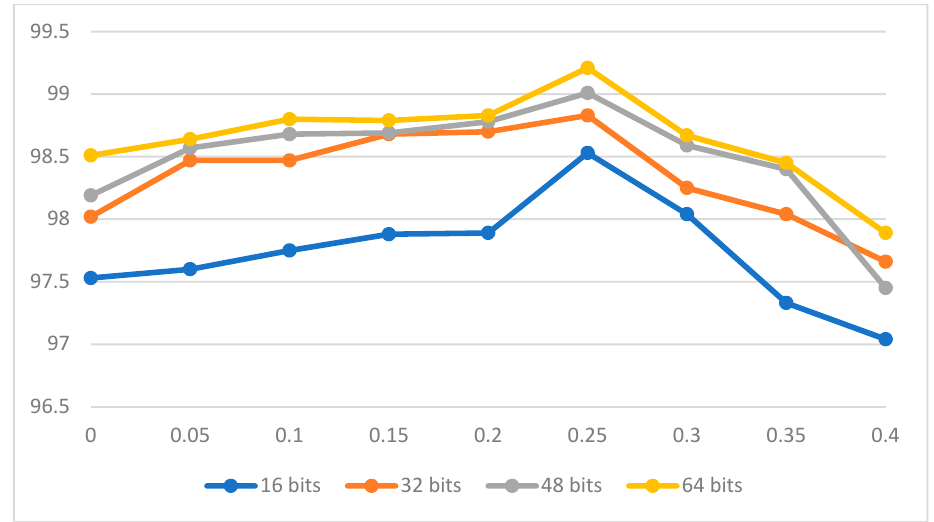
Figure 6. mAP results of different hash bits under different m on UCMD dataset.